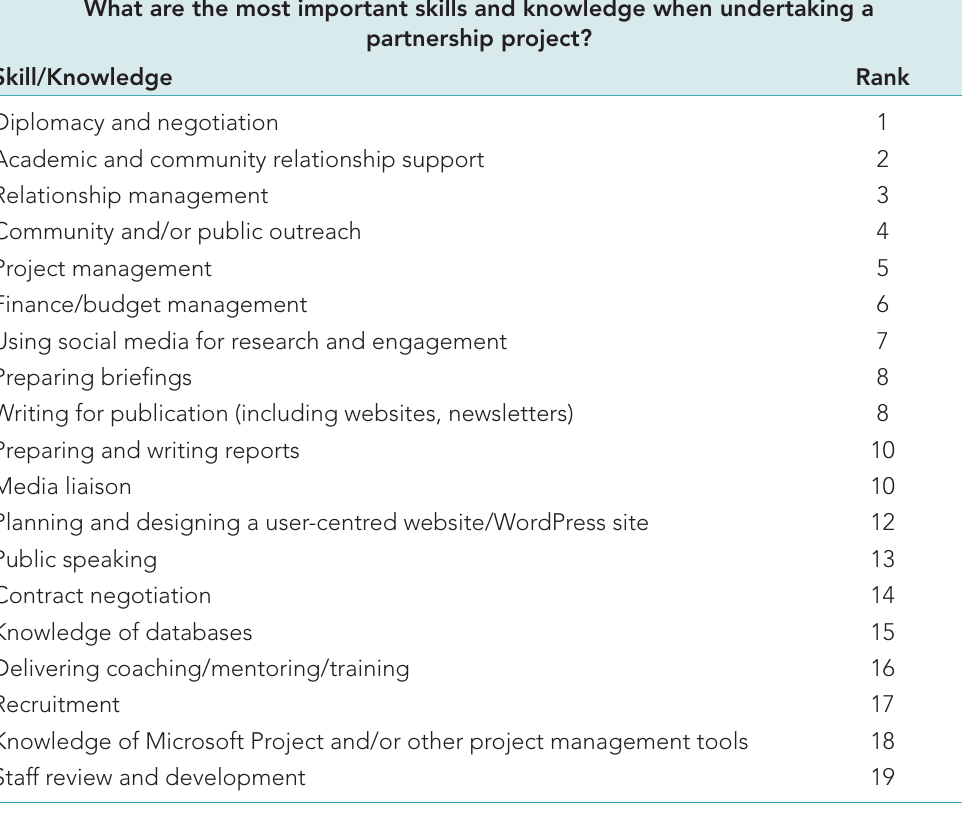
Table 1: Ranking of skills needed for the role, where 1 represents the most